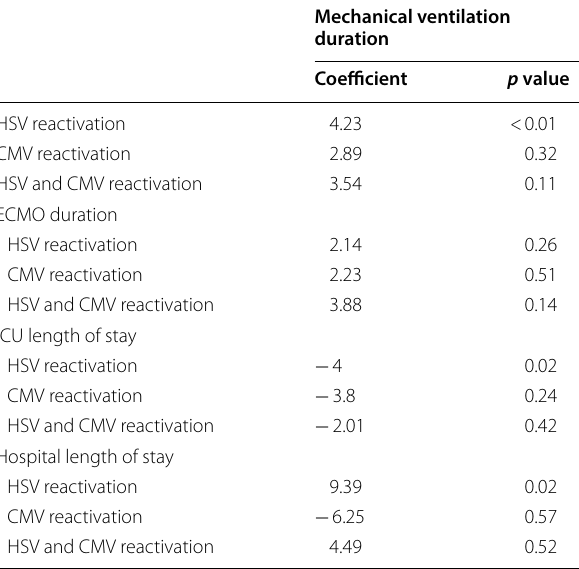
Multivariate analysis evaluating the clinical impact of HSV, CMV or HSV and CMV reactivation on MV and ECMO duration, ICU and hospital length of stay. The coefficient designates the number of days by which the different endpoints are